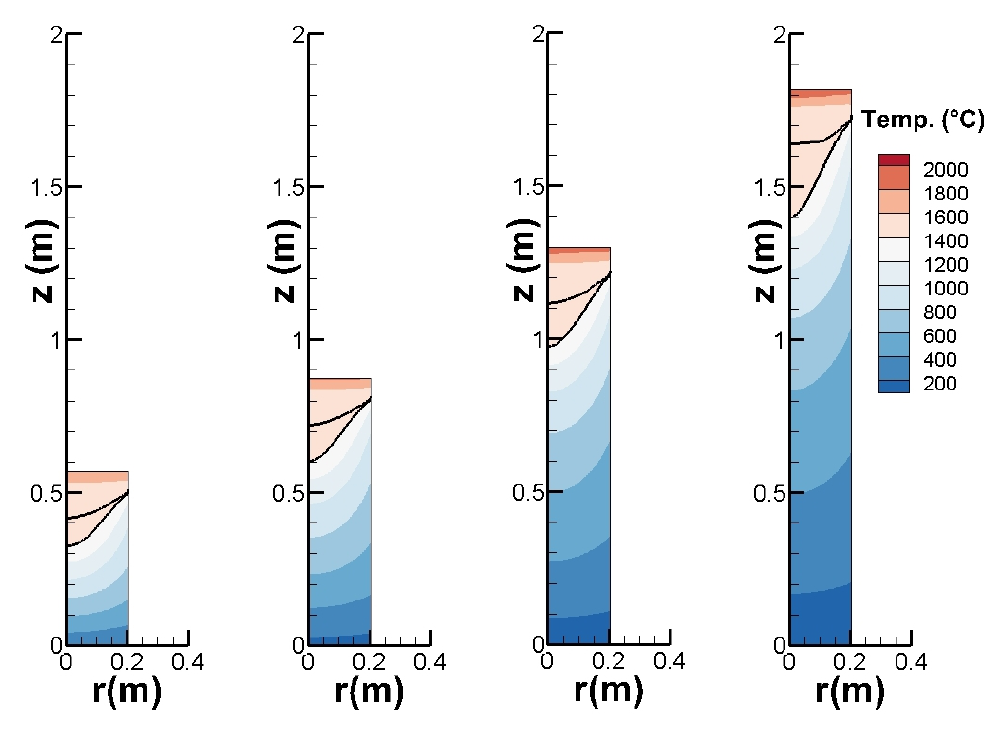
Figure 11. Computed ingot temperature map at different moments during the remelting.